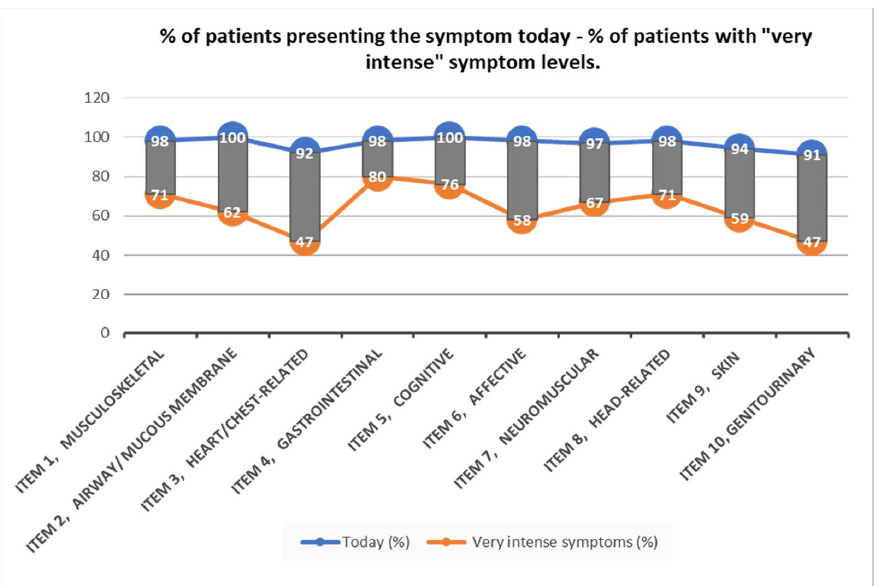
Figure 2. Percentage of patients presenting the symptom today and percentage of patients with “very intense” symptom levels.